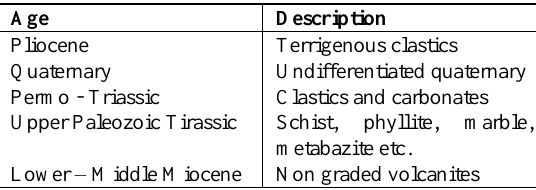
Figure 14. Lithology map of the study area